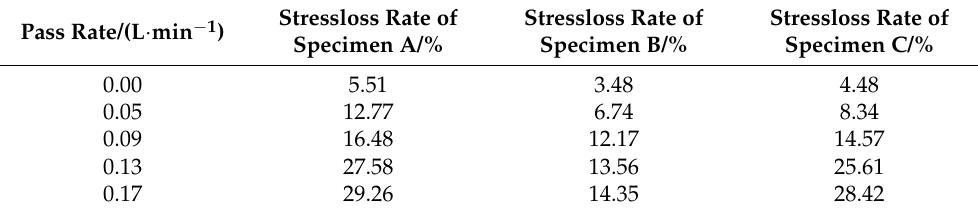
Table 5. Change rule of stress loss of specimen under different oxygen flow